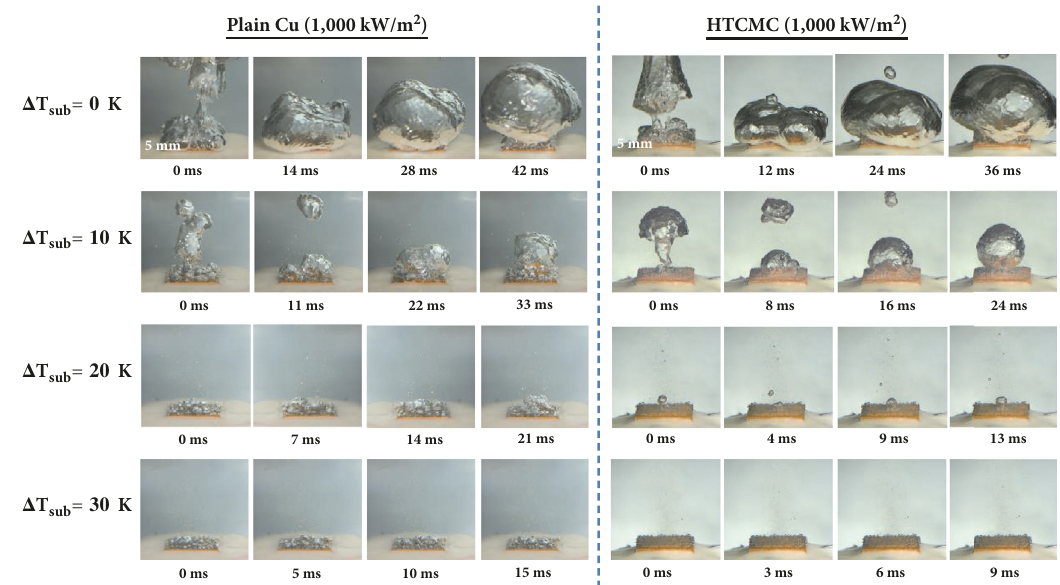
Figure 6: Nucleate boiling comparison of Plain Cu and HTCMC with different subcooled temperatures ( Δ T sub ) of 0 K, 10K, 20K, and 30K at a heat flux of 1,000kW/m 2